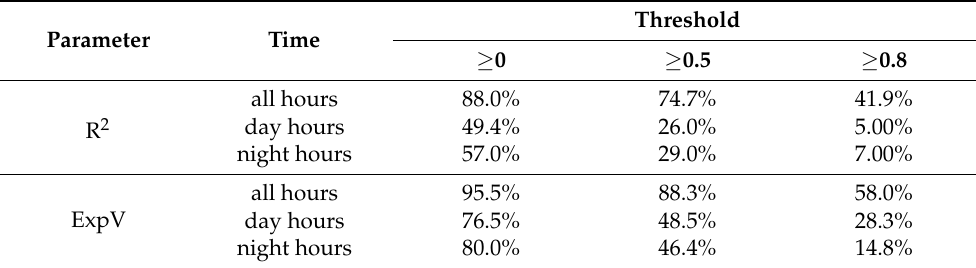
Table 5. Percentage of the forecasted days (out of 332) with R 2 and ExpV scores in a certain range (PCA-MRM (L31, mean.lag1.2)